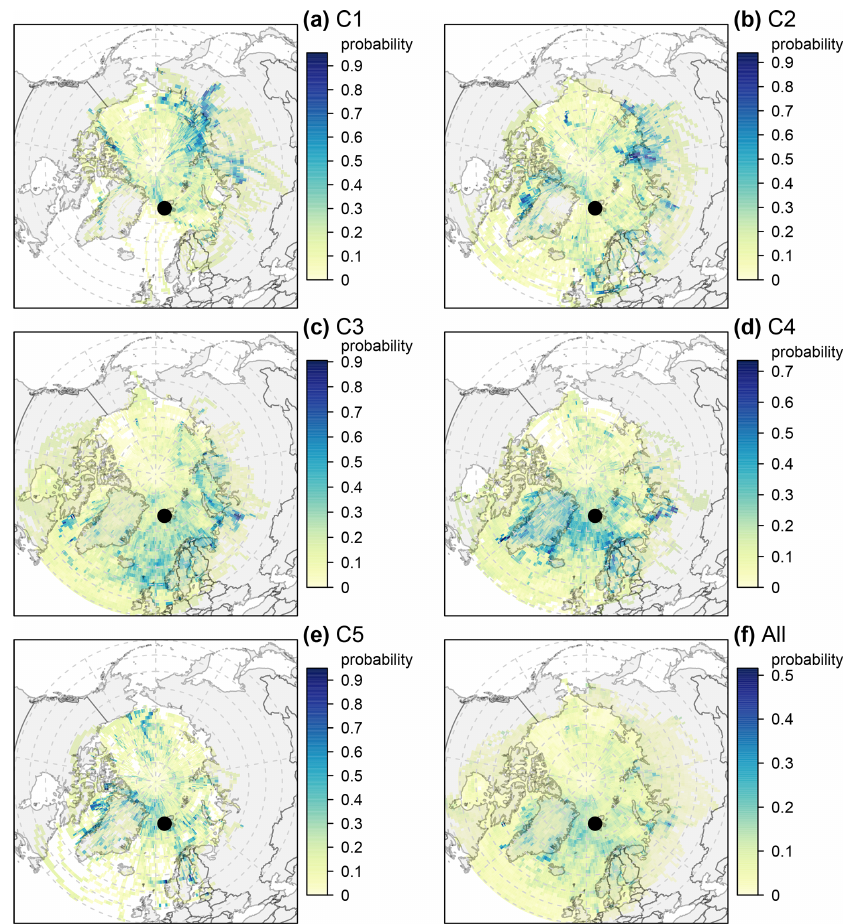
Figure 8. Potential source contribution function (PSCF) map for each cluster and all data. The GVB station is denoted as a black dot on the